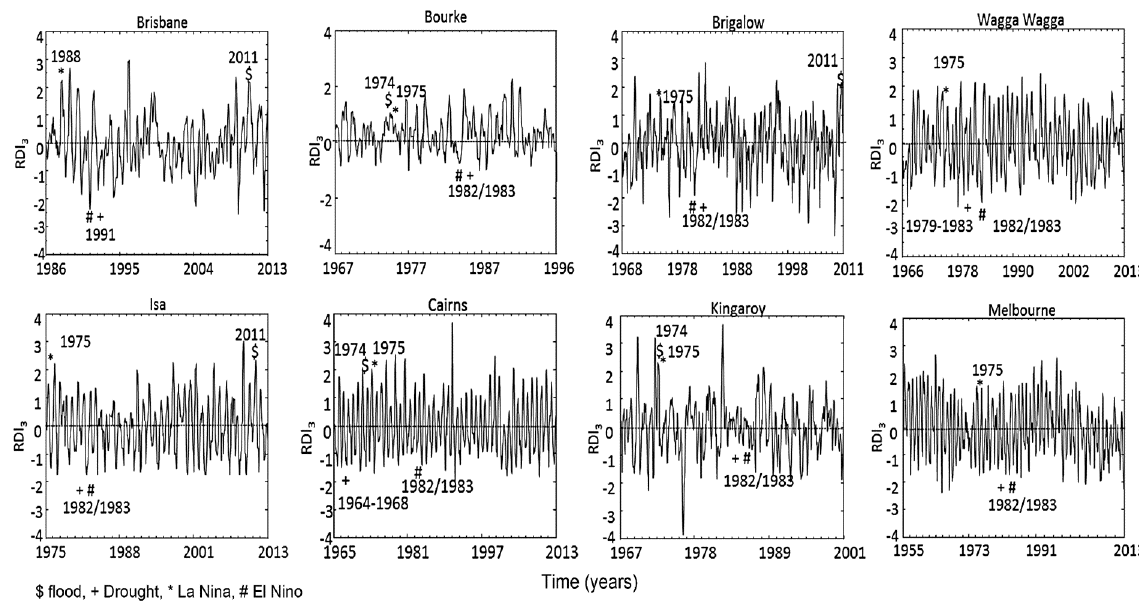
Figure C2. Calculated RDI 3 for selected locations across eastern